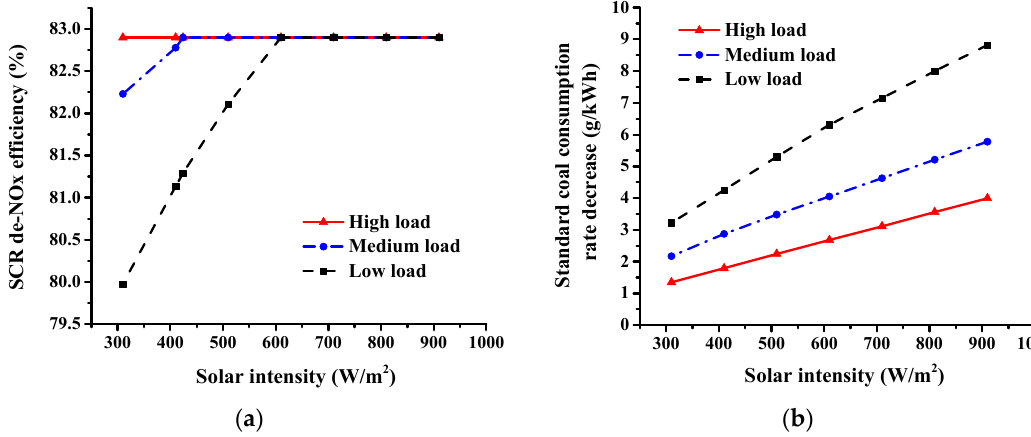
Figure 11. Influence of ( a ) solar intensity on SCR de-NO x efficiency and ( b ) standard coal consumption rate decrease.